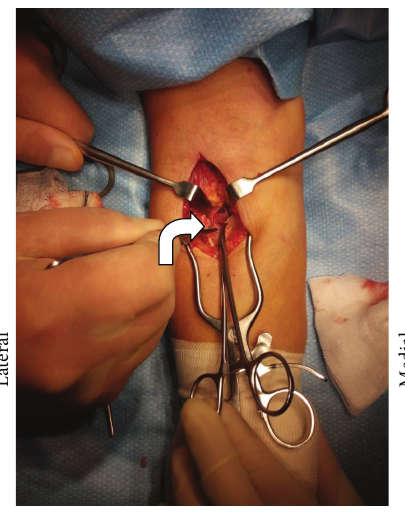
Figure 7: Deep dissection following removal of bursa, exposing radial bone (bent arrow).